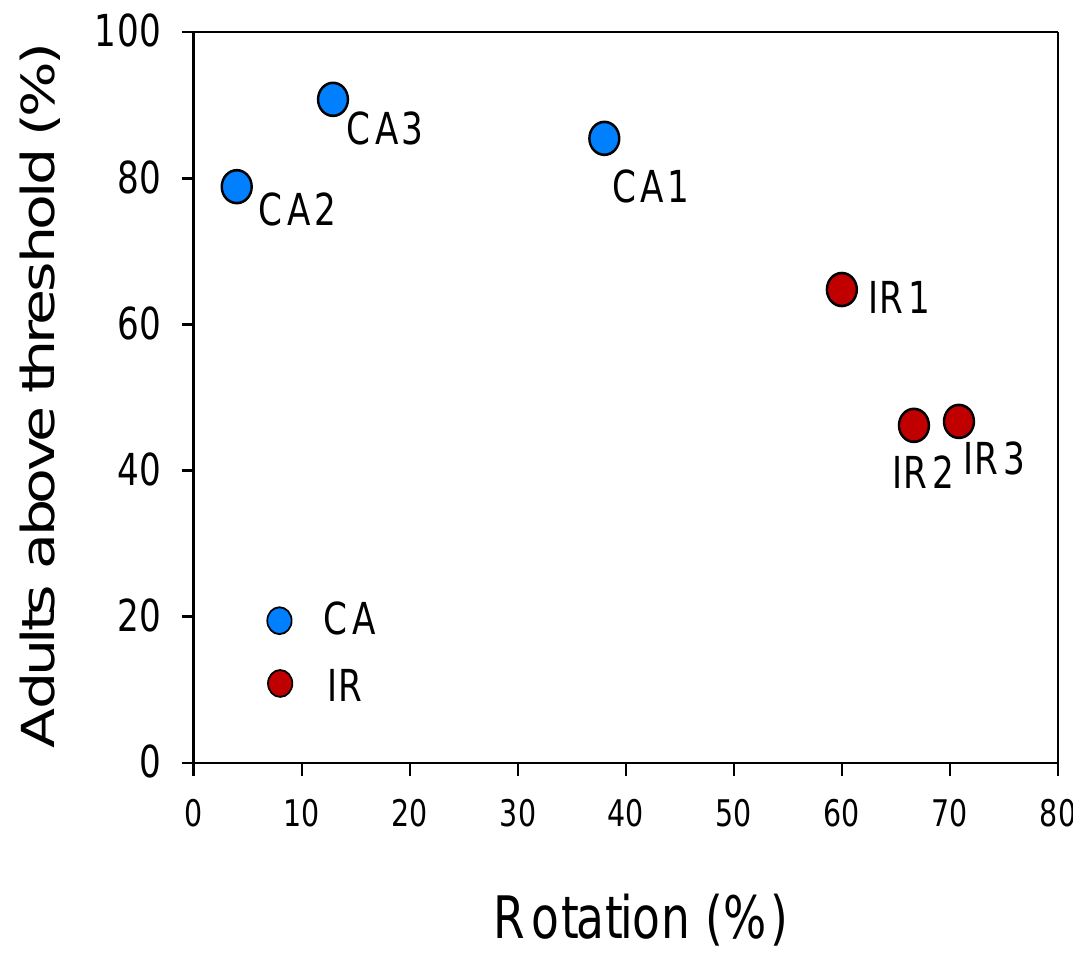
Figure 4. Relation between the percentage of cultivated land in rotation (no continuous maize) and the percentage of land where adult WCR levels exceeded the damage threshold (i.e., > 6 beetles/trap/day) accumulated in week 6. CA = chemical approach; IR = intensive rotation. Numbers are scenarios indicated in Figure 3.